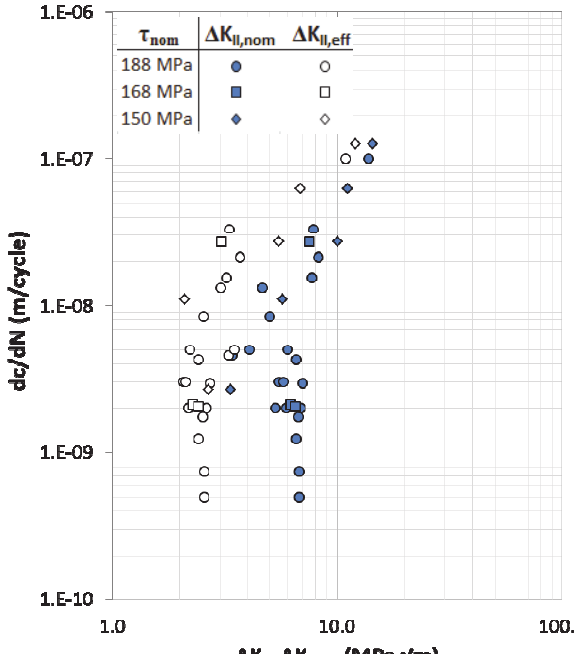
Figure 7: Experimentally measured LEFM applicable crack growth rates vs. nominal and effective mode II SIF for fully-reversed torsion